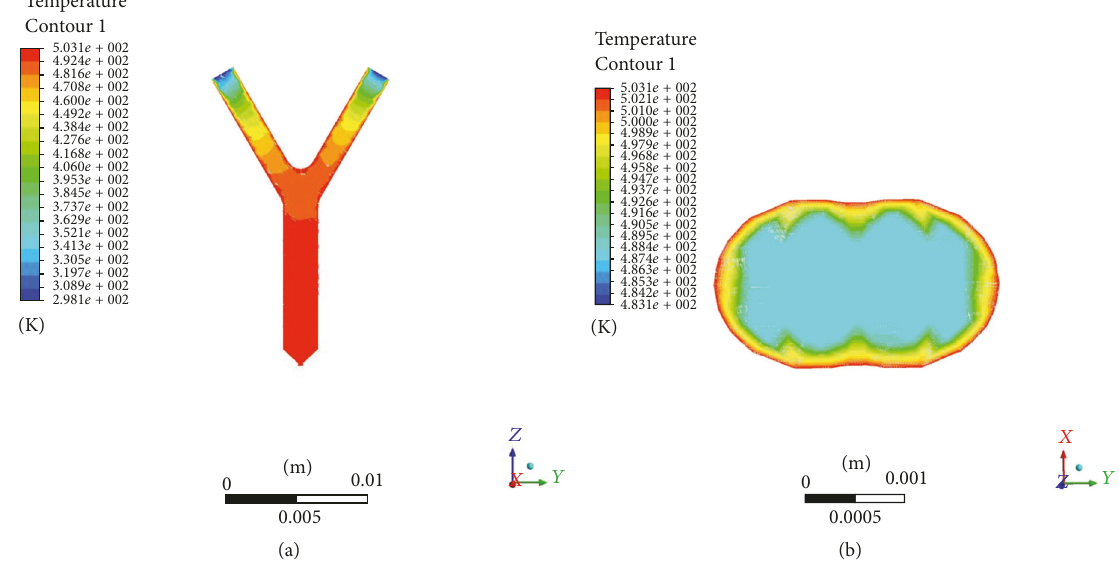
Figure 9: Temperature contours in the steady state at the temperature of 503.15 K at the time of 20 s: (a) temperature contours of the flow channel; (b) temperature contours of intersection cross section.